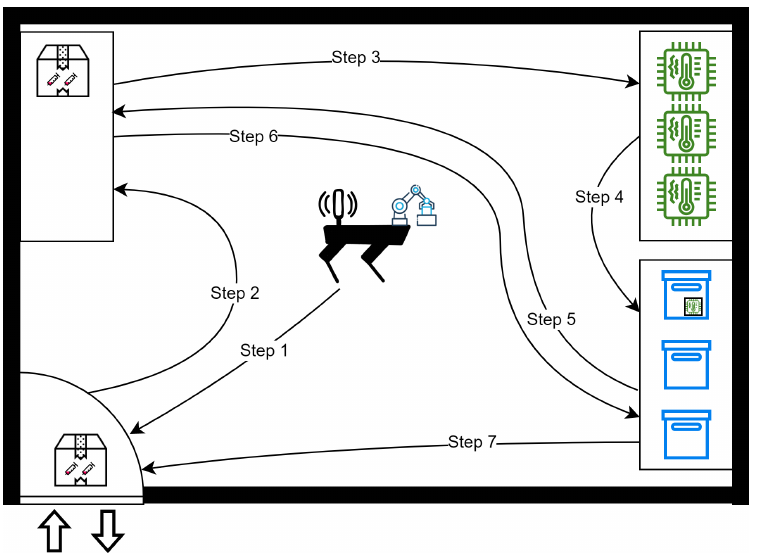
Figure 1. Vaccine logistics illustration case - Schematic of the system set-up and the minimal number of involved